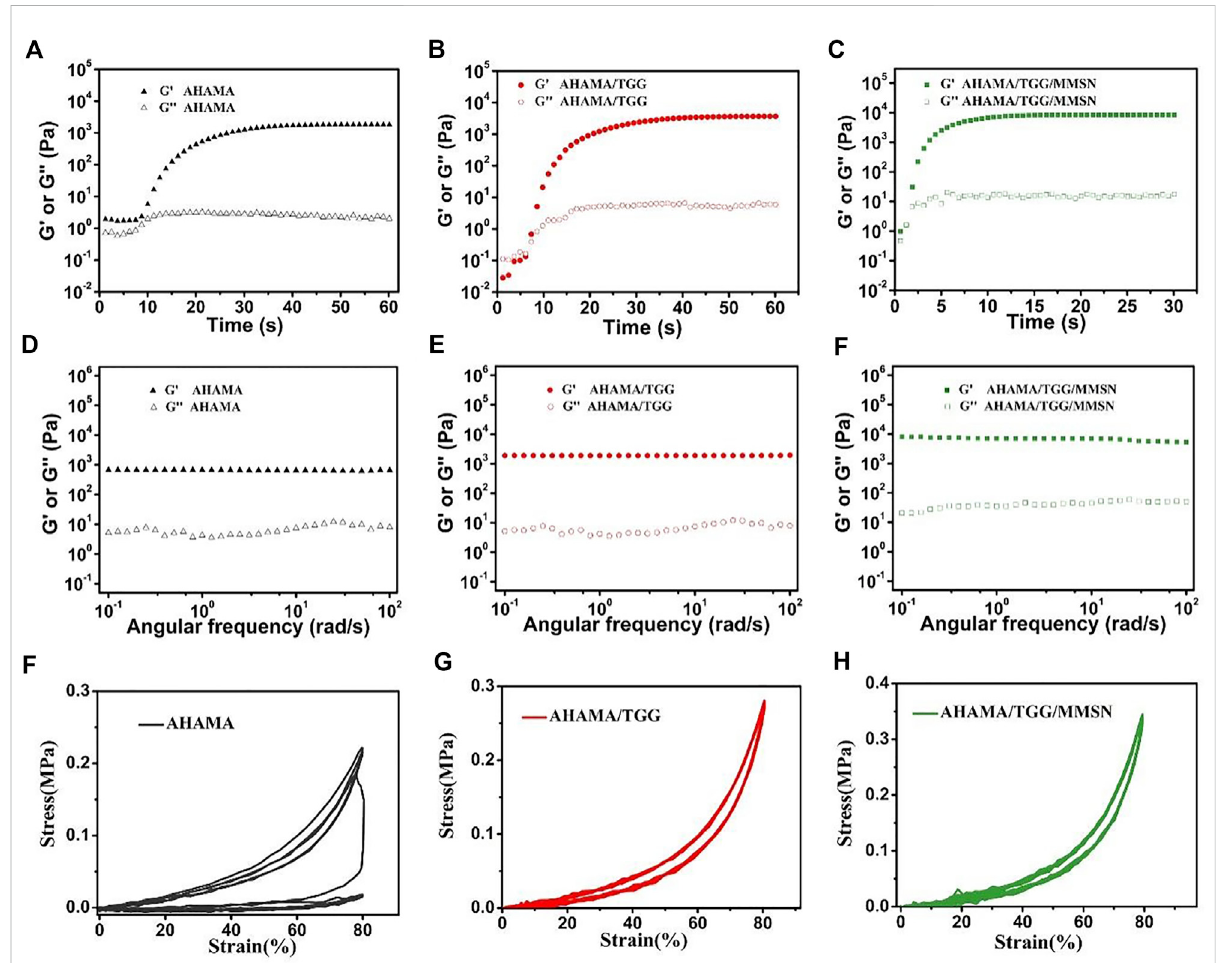
FIGURE 2 Gelation properties of AHAMA (A) AHAMA/TGG (B) and AHAMA/TGG/MMSN (C) hydrogel system using time sweeping of G ′ and G ″ under 50 mW/cm2 UV irradiation, and the correspondin) frequency-dependent at a strain of 1% (D – F) Twenty successive compressive loading-unloading cycles for the AHAMA (F) AHAMA/TGG (G) and AHAMA/TGG/MMSN (H) hydrogels with a strain of